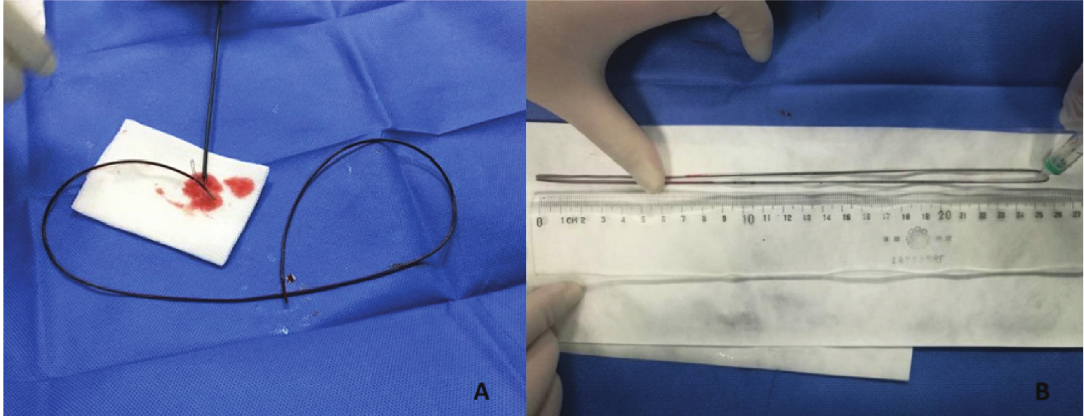
Figure 4. Images of the real broken catheter after being taken out of the body: (A) the broken catheter and (B) the length of the catheter measuring 50 cm.